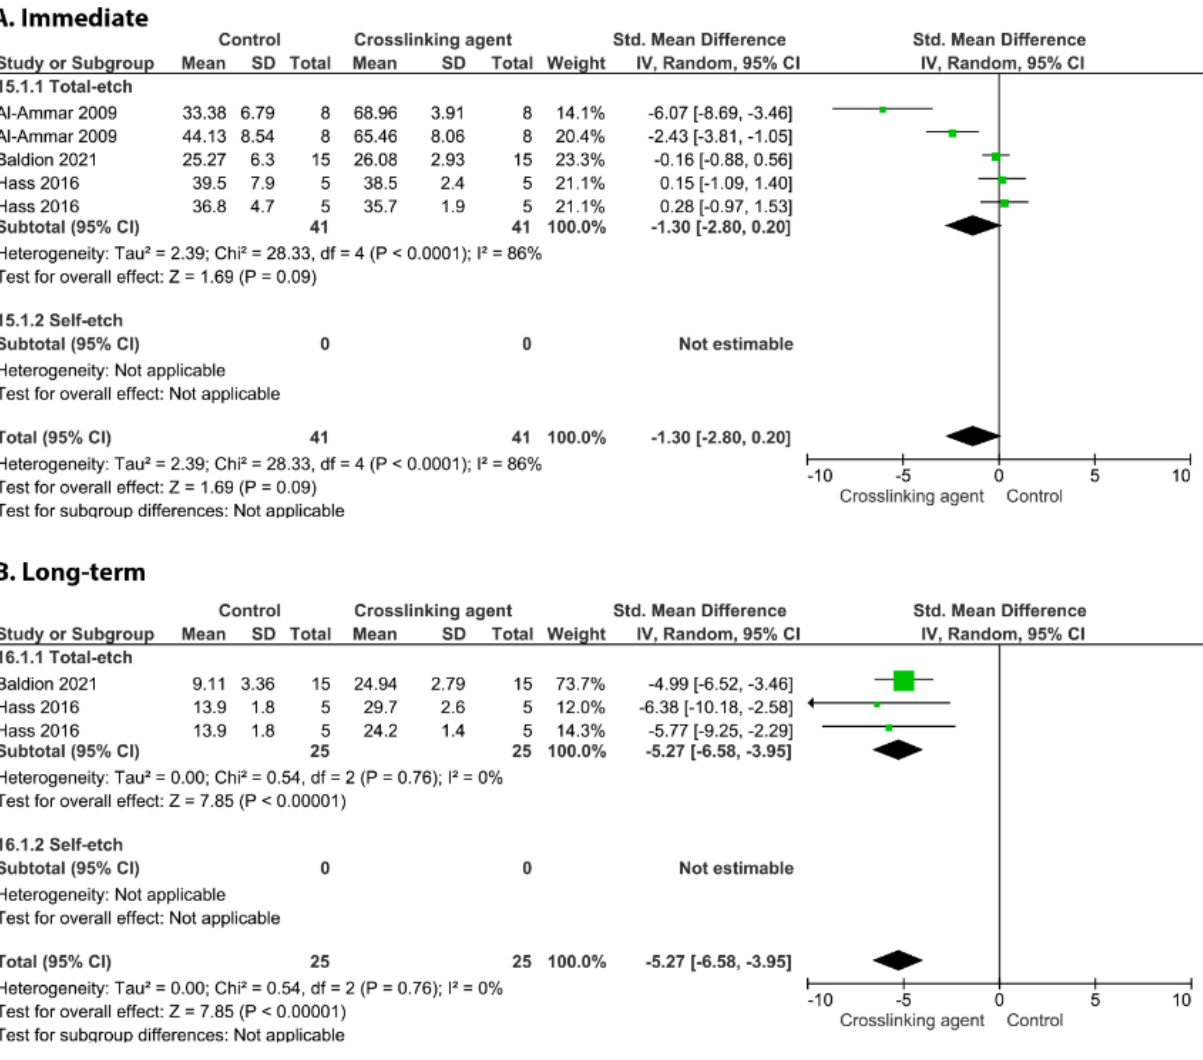
Figure 6. Forest plot of the immediate ( A ) and long-term ( B ) bond strength comparison between the glutaraldehyde crosslinking agent and the control according to the adhesive used, [17,105,108].